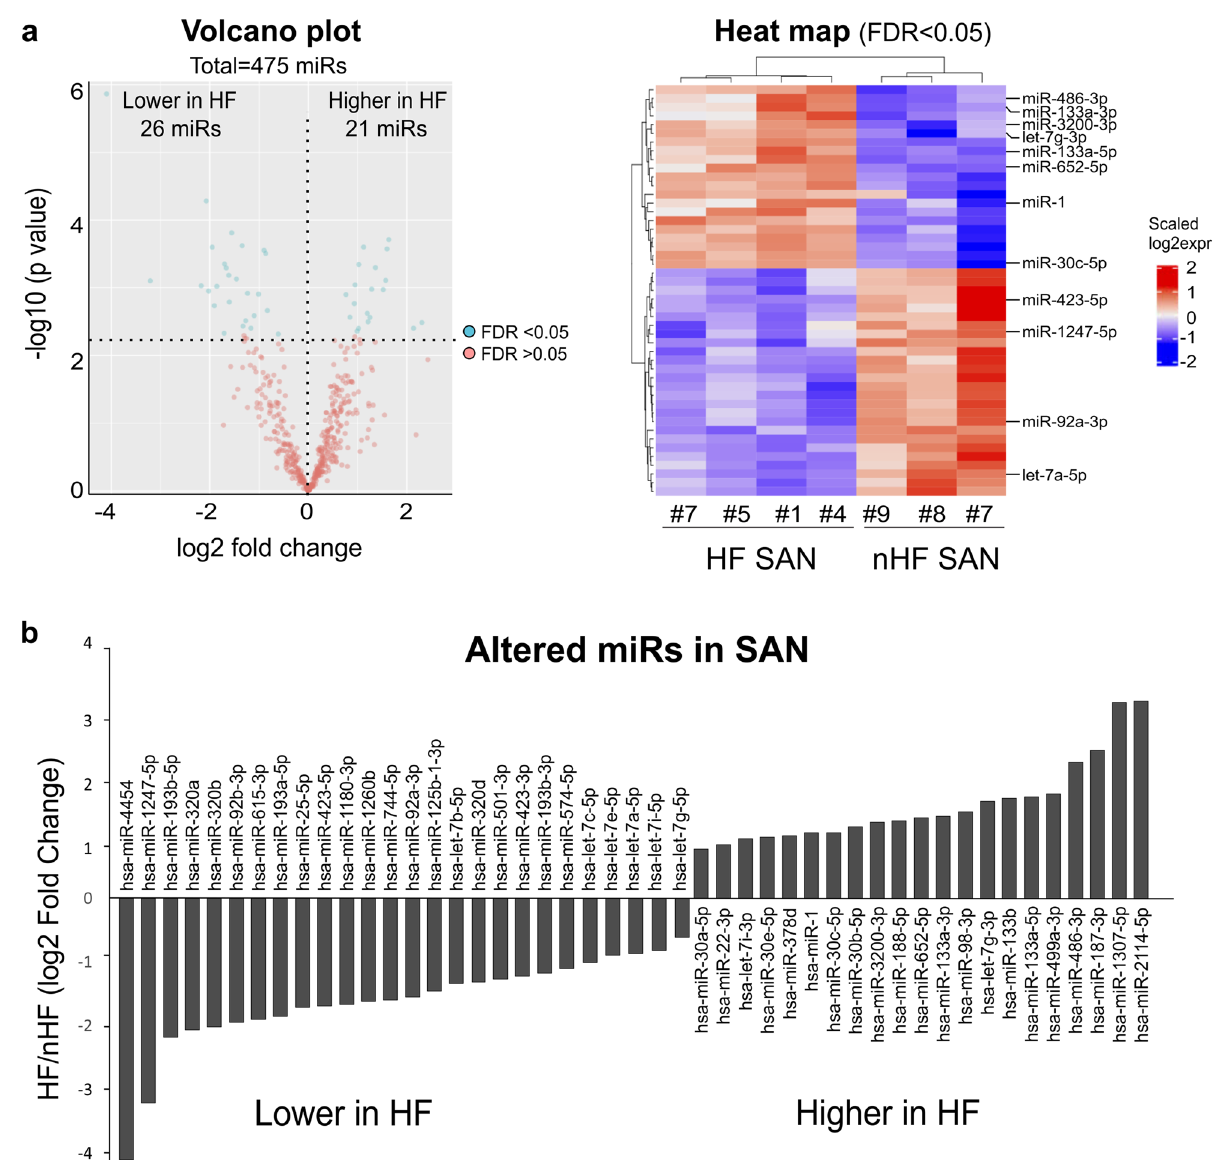
Figure 5. Altered miRs in HF human SAN. ( a ) Volcano plot (left) and heat map (right) of altered miRs in the HF human SAN. ( b ) Bar graph shows significantly altered miRs during HF in the human SAN as detected by NGS. Plots and heat maps were generated with R 3.6.3. HF indicates heart failure; NGS, next generation sequencing; SAN, sinoatrial